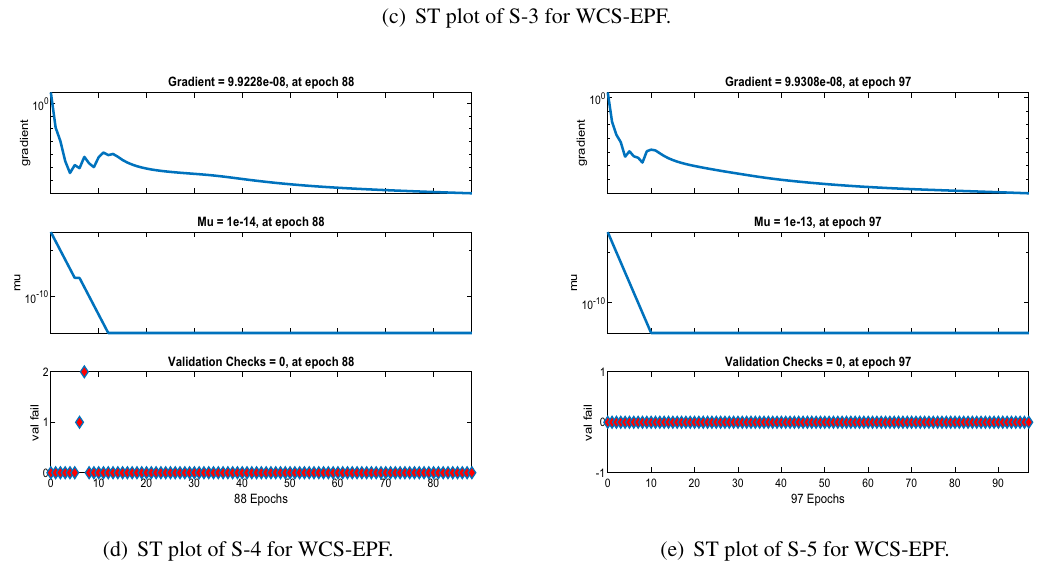
(e) ST plot of S-5 for WCS-EPF.